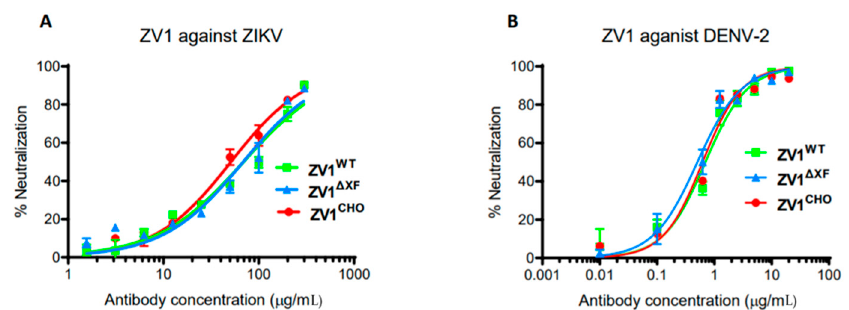
Figure 2. Neutralization of ZIKV and DENV by ZV1 mAb glycovariants. Serial dilutions of ZV1 mAb glycovariants were co-incubated with 100 PFU of ZIKV ( A ) or DENV-2 ( B ) and Vero cells for 3 (ZIKV) or 4 (DENV-2) days. Plaques were counted, and percent neutralization and EC 50 were calculated. Experiments were performed at least twice with technical triplicates for each sample. Bars represent the SD of the mean.